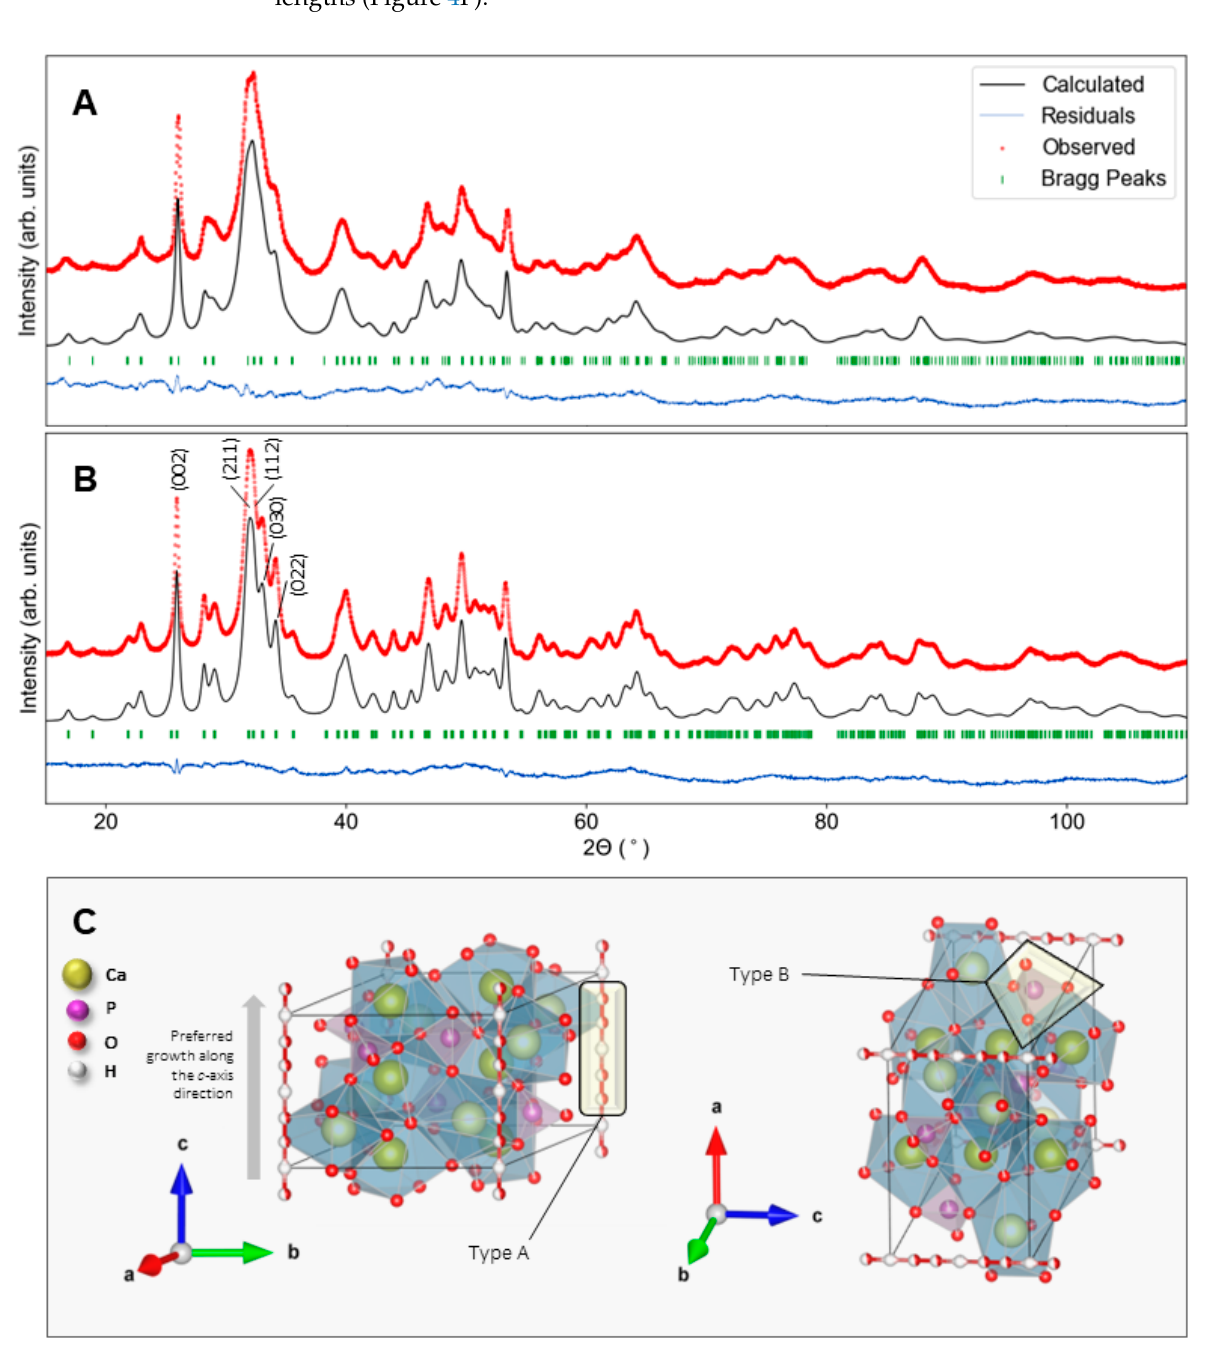
Figure 3. Derivative-difference minimization refinement (black) and residuals (blue) of measured X-ray powder diffraction patterns (red) for substituted HAP. Minerals were synthesized via homoge- neous enzymatic catalysis at 37 ◦ C, pH 7.4 using [S] 0 = 7.0 mM and either ( A ) no added fluoride or ( B ) at [F − ] 0 = 1.2 mM. The calculated patterns were refined using ( A ) models for carbonate-substituted HAP (PDF4+ # 00-066-0147) and ( B ) fluoride- and carbonate-substituted HAP (PDF4+ # 04-015-8299), respectively (green). ( C ) Visualization of the crystallographic structure of HAP indicating sites of ionic substitution in the